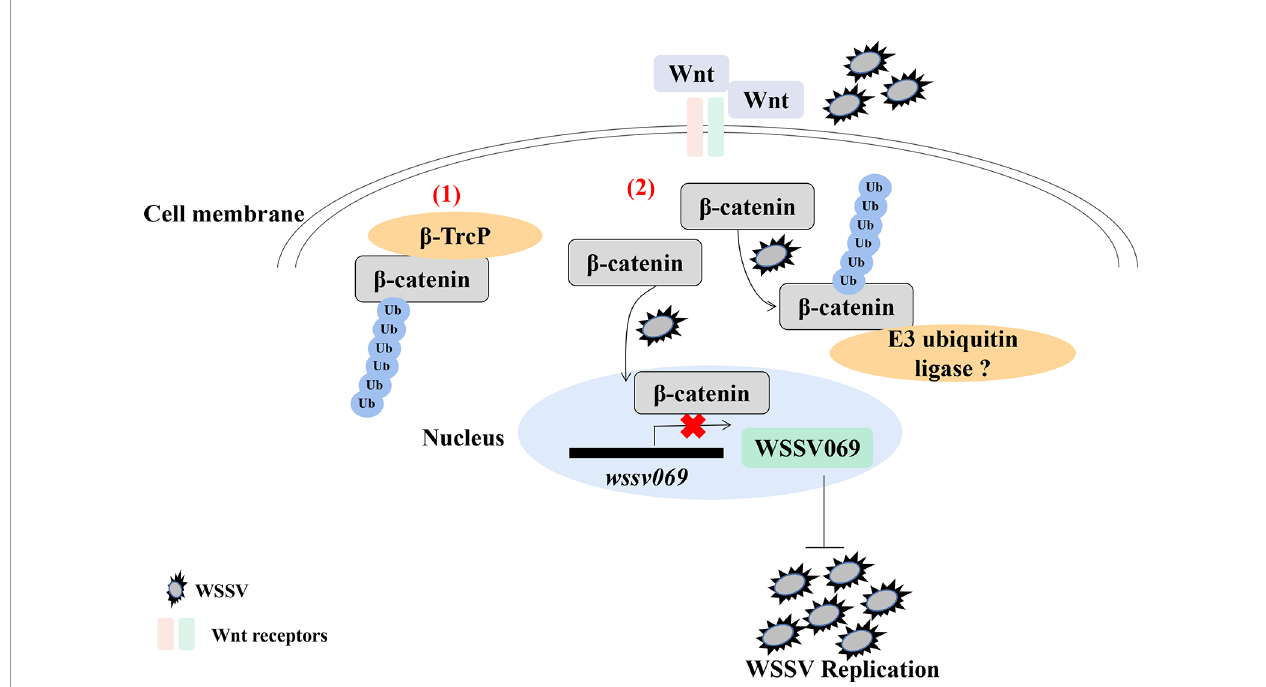
FIGURE 2 | Ubiquitination of b -catenin is important for penaeid shrimp antiviral immune response. b -catenin is a key regulator in the Wnt/ b -catenin signaling pathway. (1) In mammals, b -catenin in cytoplasm could be ubiquitinated by an E3 ubiquitin ligase b -TrcP for degradation (62, 63). (2) In the cytoplasm of shrimp, b -catenin is ubiquitinated by WSSV infection, which also promotes the translocation of b -catenin into nucleus to inhibit the expression of virus immediate early gene wssv069 . b -catenin can also interact with wssv069 (61). Thus, b -catenin plays a positive role through ubiquitination to inhibit WSSV replication during infection. However, which protein could ubiquitinate b -catenin in penaeid shrimp has not been